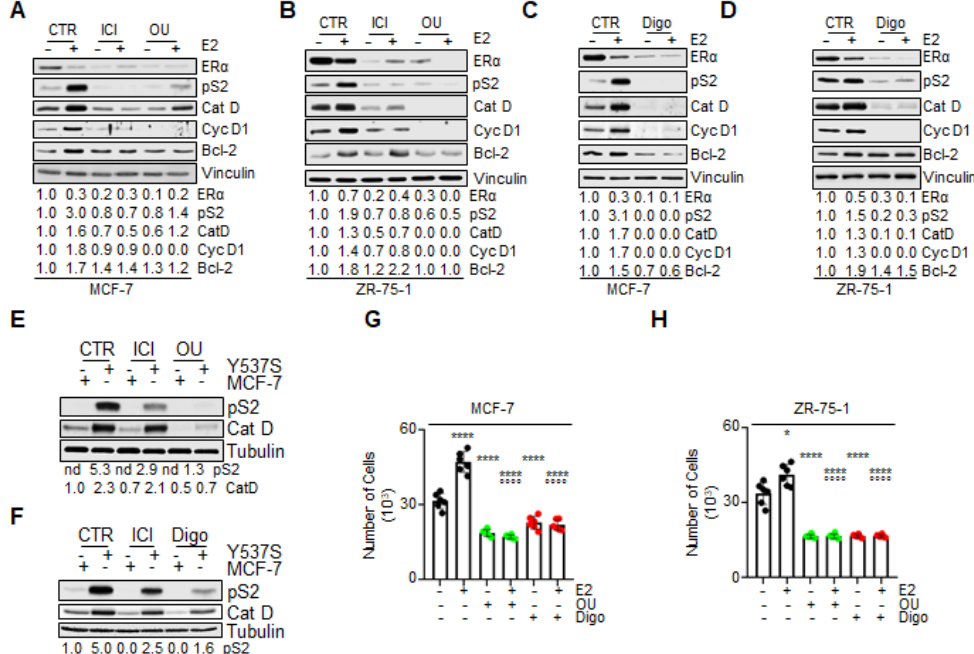
Figure 7. The impact of ouabain and digoxin on E2:ER α signaling in breast cancer cells. Western blotting of ER α , presenilin-2 (pS2), cathepsin D (Cat D), cyclin D1 (Cyc D1), and Bcl-2 expression in MCF-7 ( A ), and ZR-75-1 ( B ) cells, treated, or untreated (CTR) with ouabain (OU–100 nM) or ICI182,780 (ICI–100 nM), in the presence of 17 β -estradiol (E2 1 nM), for 24 h. The loading control was performed by evaluating vinculin expression in each filter. All experiments were performed in triplicates. Western blotting of ER α , presenilin-2 (pS2), cathepsin D (Cat D), cyclin D1 (Cyc D1), and Bcl-2 expression in MCF-7 ( C ), and in ZR-75-1 ( D ) cells treated, and untreated (CTR) with digoxin (Digo—1000 nM), in the presence of 17 β -estradiol (E2 1 nM), for 24 h. The loading control was performed by evaluating vinculin expression in each filter. All experiments were performed in triplicates. Western blotting of presenilin-2 (pS2), cathepsin D (Cat D), and caveolin-1 (Cav-1) in MCF-7 ( E ) and Y537S ER α -expressing MCF-7 (Y537S) ( F ) cells, treated, and untreated (CTR) with ouabain (OU—100 nM), digoxin (Digo—1000 nM), or ICI182,780 (ICI—100 nM), for 24 h. The loading control was performed by evaluating tubulin expression in each filter. All experiments were performed twice. Number of MCF-7 ( G ) and ZR-75-1 ( H ) cells, treated, and untreated (-) with ouabain (OU—100 nM), or with digoxin (Digo—1000 nM)